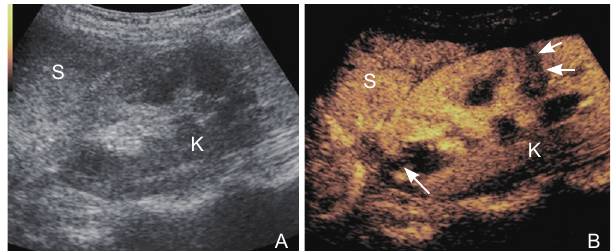
Figure 3 A male patient with left flank injury was admitted to hospital. Dual grey-scale (A) and contrast (B) ultrasound imaging detect an avascular perfusion defect at junction of mid and low poles which confirmed as kidney laceration at surgery. [Provided by Dr. Faqin Lv from